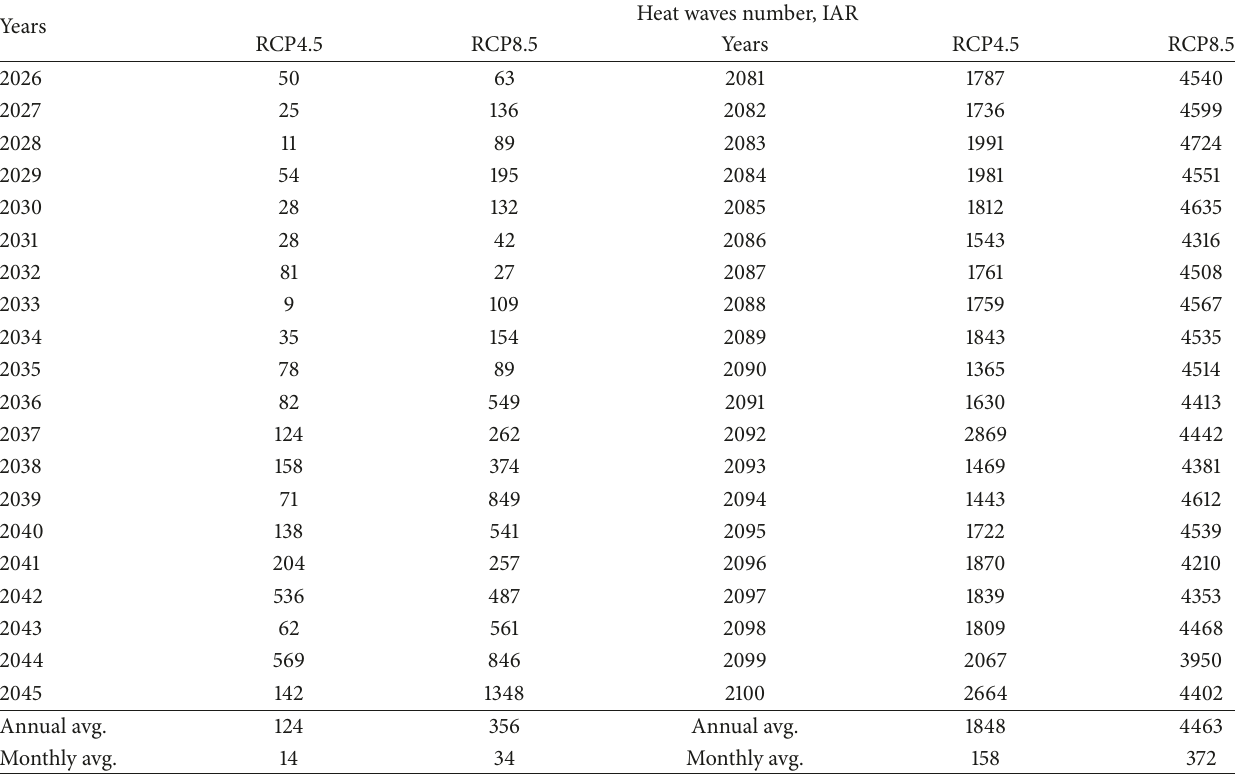
Table 1: Total annual heat waves number for the whole